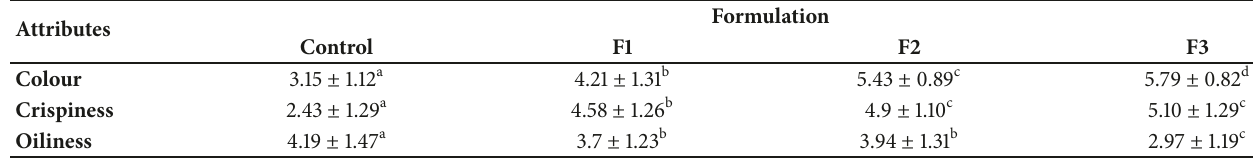
Table 4: Results of the sensory attributes (colour, crispiness, and oiliness) evaluated for the different snacks formulation ∗ . Attributes